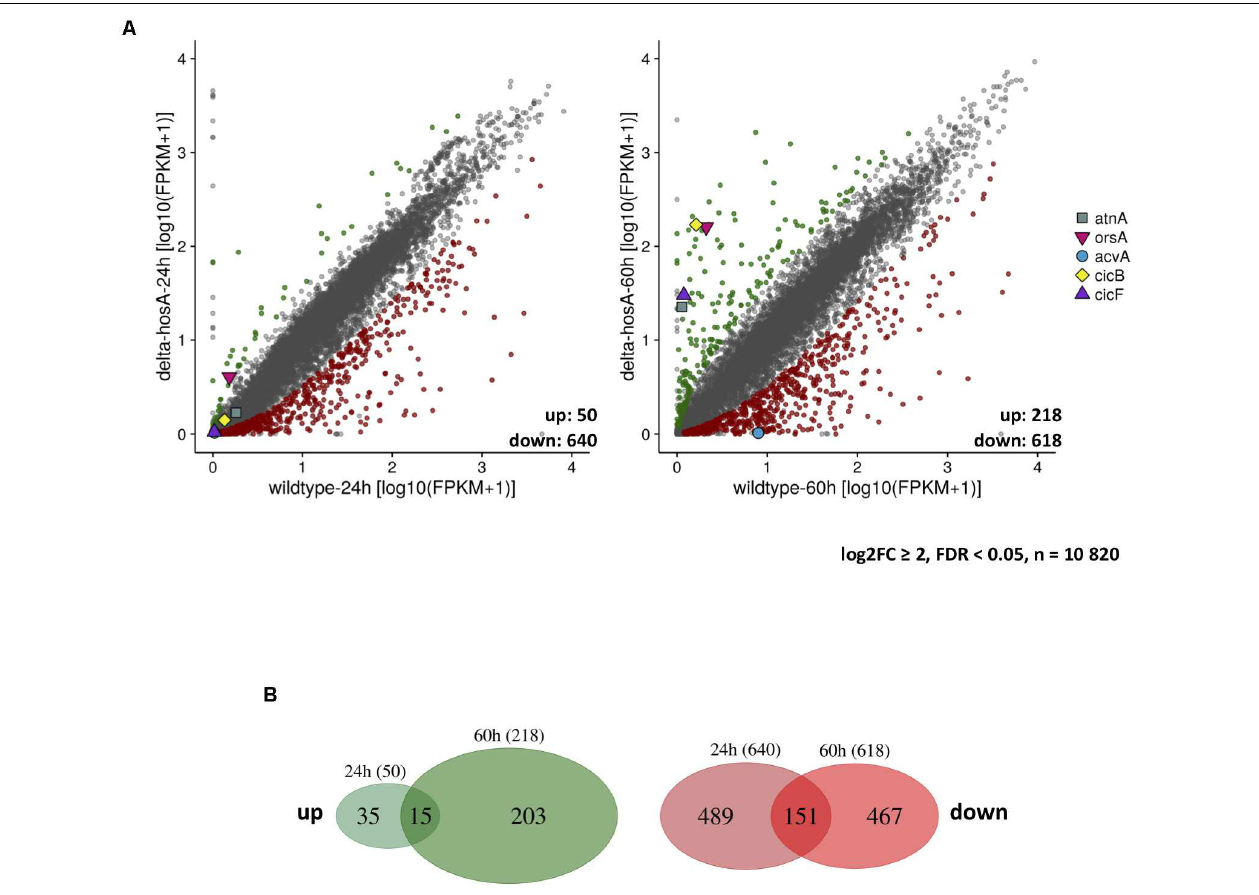
FIGURE 5 | RNA-Seq analysis of differentially expressed genes in hosA mutants. Scatter plots show the expression values (log10[FPKM + 1]) for every annotated gene ( n = 10.820) after 24 and 60 h of growth in GMM at 37 ◦ C. An additional cutoff (log2FC > 2/FDR < 0.05) for differentially expressed genes was applied. Dots within these cutoff criteria are displayed in gray and not considered as being affected by hosA deletion. Green dots indicate significantly upregulated, red dots significantly downregulated genes in hosA mutants. Biosynthetic cluster members of orsellinic acid ( orsA ), aspercryptin ( atnA ), cichorine ( cicB , cicF ), and penicillin ( acvA ) are highlighted, total number of up- and down-regulated genes are given (A) . Venn diagrams below illustrate the distribution of up- (green) and down-regulated (red) genes in the hosA mutants in 24 or 60 h cultures. Numbers of overlapping and non-overlapping up- and downregulated genes are show (B) .